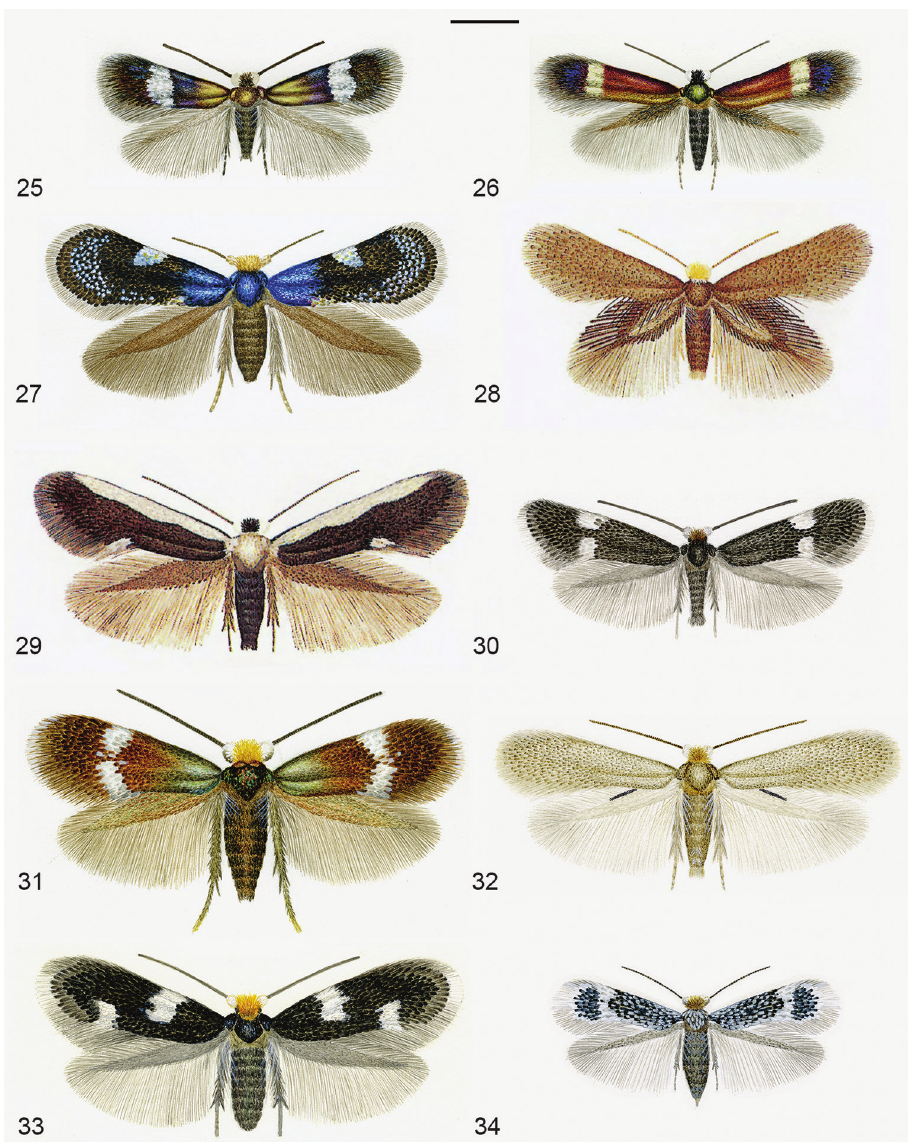
Figures 25–34. Diversity of Nepticulidae, all on same scale. 25 Enteucha acetosae , male, Austria 26 Stig- mella mespilicola , male, Switzerland, holotype 27 Roscidotoga callicomae , female paratype, Australia, NSW 28 Menurella libera , male holotype, Australia, NSW 29 Pectinivalva caenodora , male holotype, Australia, NSW 30 Glaucolepis lituanica , male, Austria 31 Bohemannia auriciliella , male, The Netherlands 32 Tri- furcula iberica , male paratype, Spain 33 Fomoria weaveri , female, Sweden 34 Parafomoria helianthemella , female, Czech Republic. Scale 1 mm. Watercolours by Roland Johansson, 25, 26, 31 and 33 published earlier by Johansson et al. (1990), 28 and 29 by Hoare et al. (1997). The left wings of 32 and 34 are digi- tally mirrored images of the right wings. These figures may be reproduced given that their author Roland Johansson and the present publication are